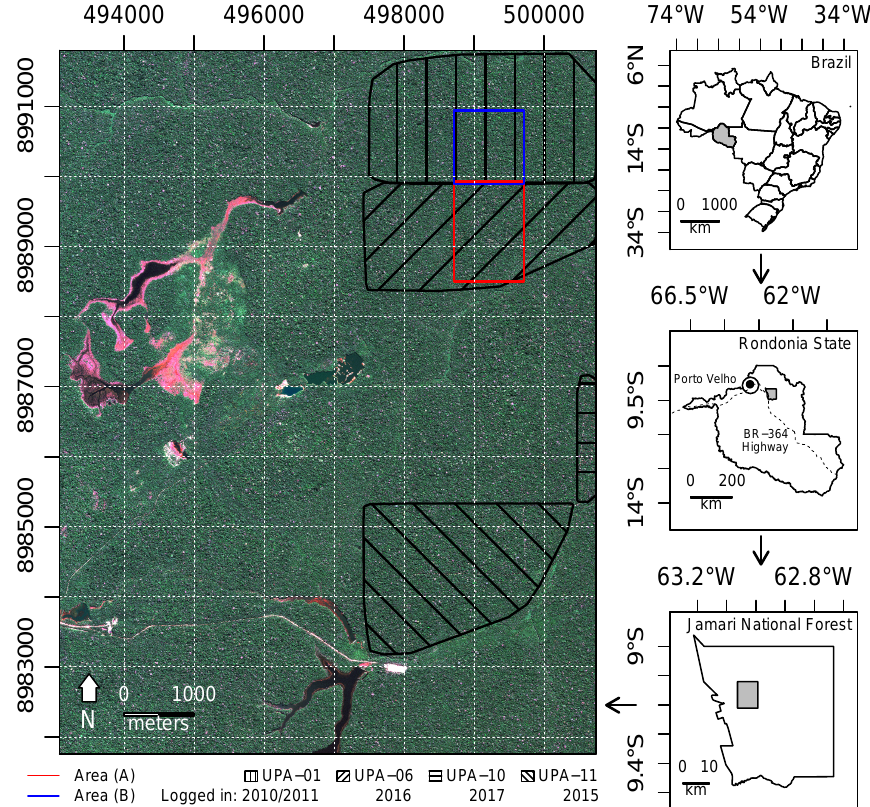
Figure 1. Study area at the Jamari National Forest, Rond ô nia state, Brazil. The background of the left image is a true color composite from the GeoEye-1 satellite acquired on 02 July 2017 (UTM, datum WGS-84). The red and blue rectangles represent the areas A and B covered by the LiDAR datasets, which were analyzed in Sections 3.1 and 3.3, respectively. The black lines represent the boundaries of the UPAs. The satellite image is courtesy of the DigitalGlobe